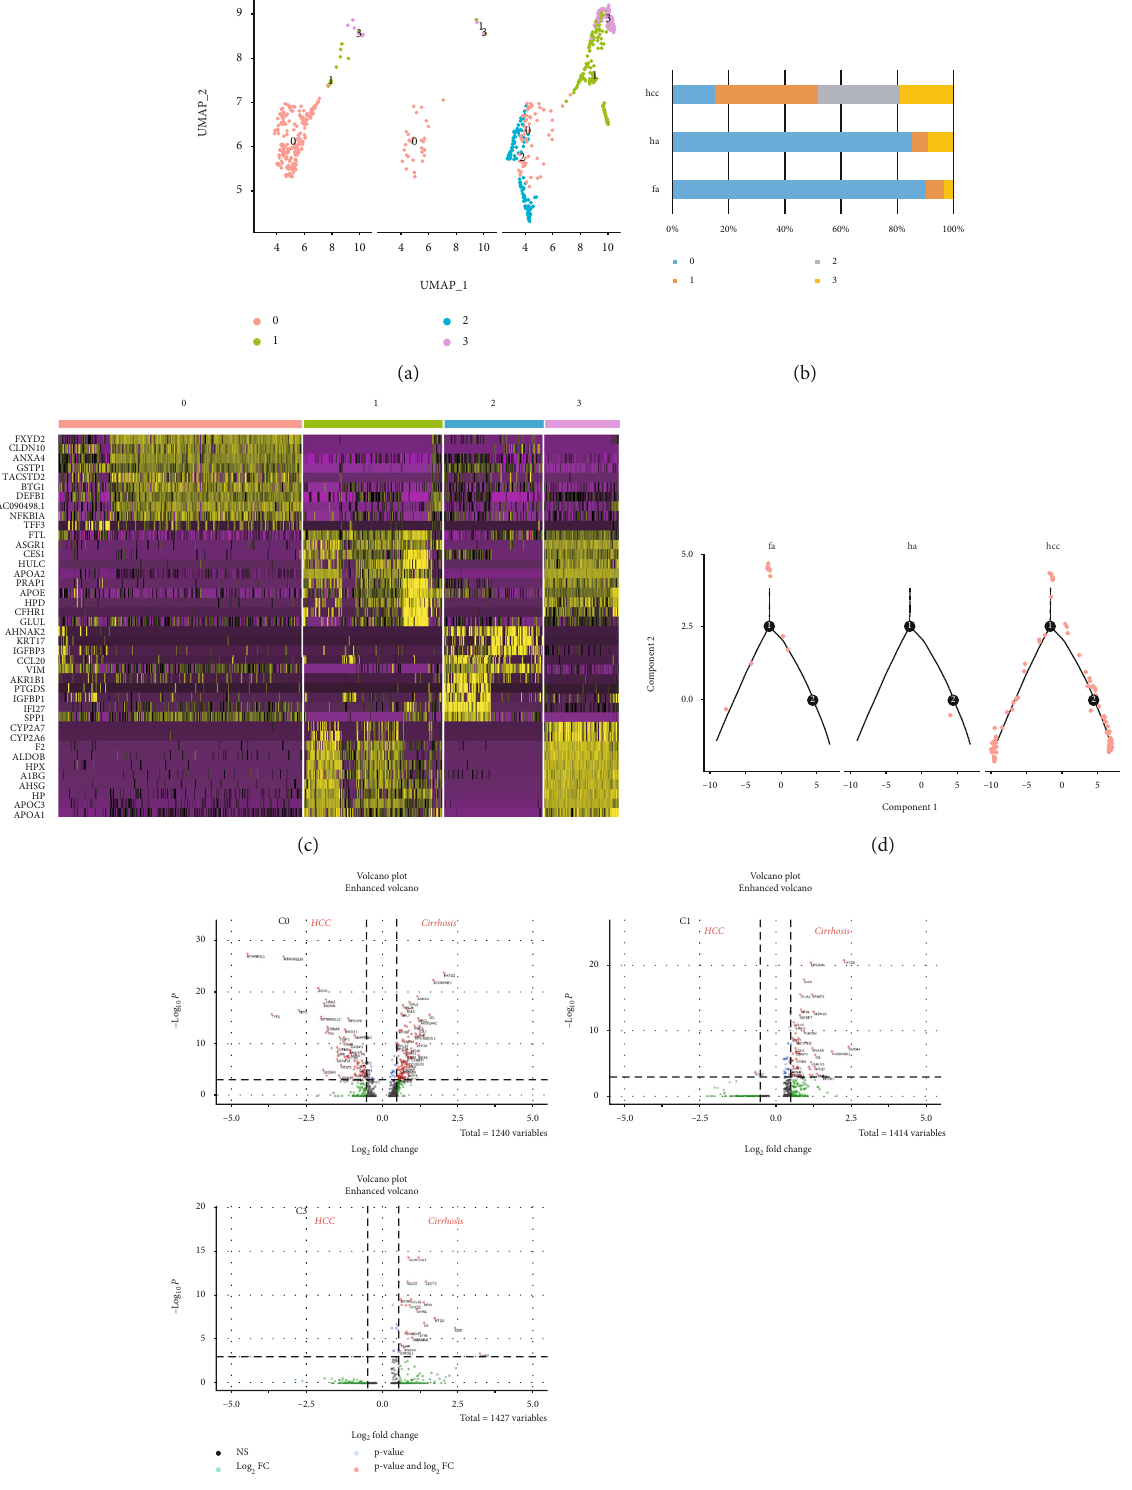
APOA1APOC3HPAHSGA1BGHPXALDOBF2CYP2A6CYP2A7SPP1IFI27IGFBP1PTGDSAKR1B1VIMCCL20IGFBP3KRT17AHNAK2GLULCFHR1HPDAPOEPRAP1APOA2HULCCES1ASGR1FTLTFF3NFKBIAAC090498.1DEFB1BTG1TACSTD2GSTP1ANXA4CLDN10FXYD2 Figure 3: Subcluster analysis of the epithelial cells. (a) UMAP diagram depicts 4 subtypes of the epithelial cells. (b) Bar graphs quantify and compare the proportion of epithelial cell subtypes of healthy (ha), fi brosis (fa), and HCC (hcc) patients. (c) Di ff erential genes of 4 epithelial cell subtypes. (d) Analysis of the trajectory of cluster 1 in the healthy (ha), fi brosis (fa), and HCC (hcc) state. (e) Volcano plots show the DEGs between fi brosis and HCC in 3 epithelial cell subtypes; C2 exists only in the